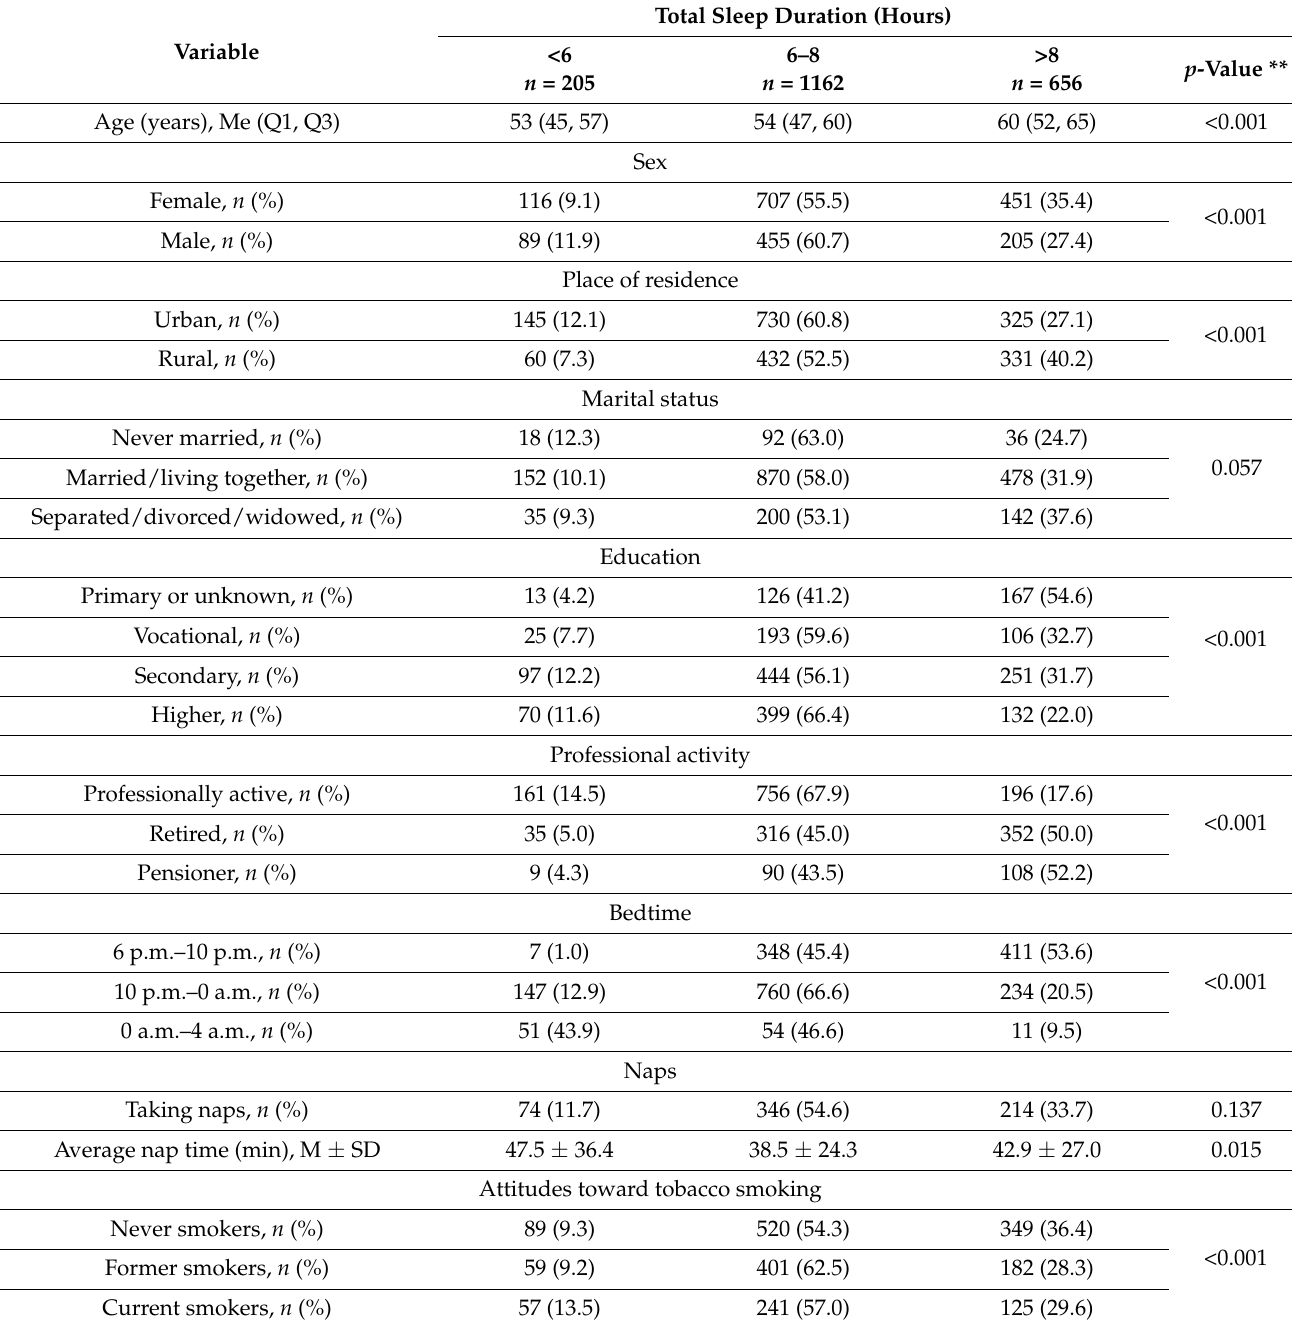
Table 1. Total sleep duration in the study